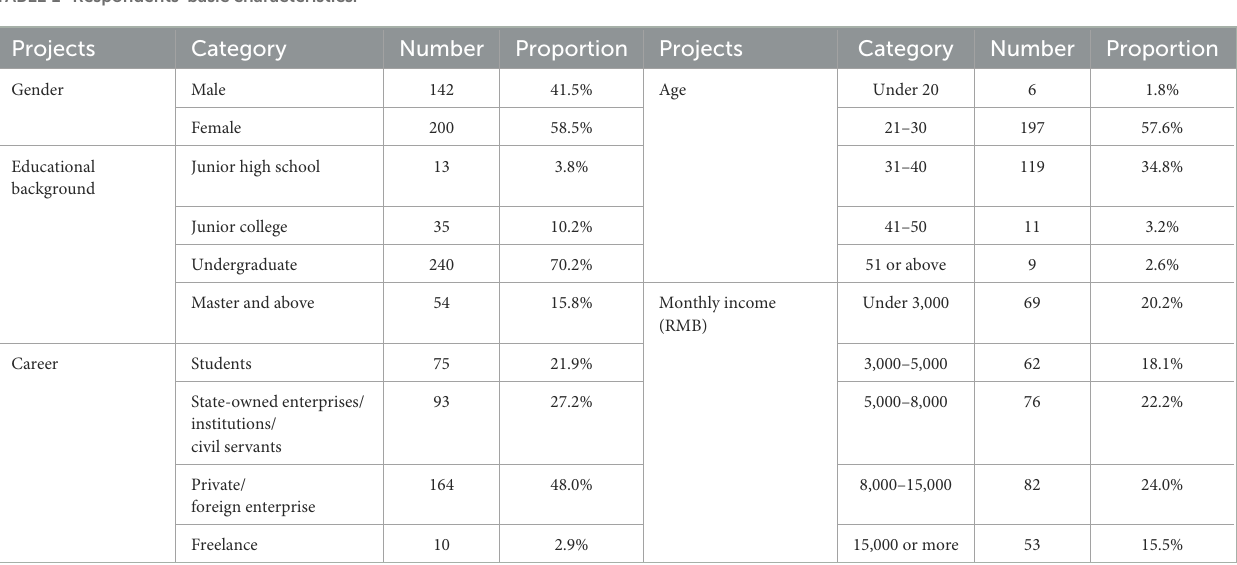
TABLE 1 Respondents’ basic